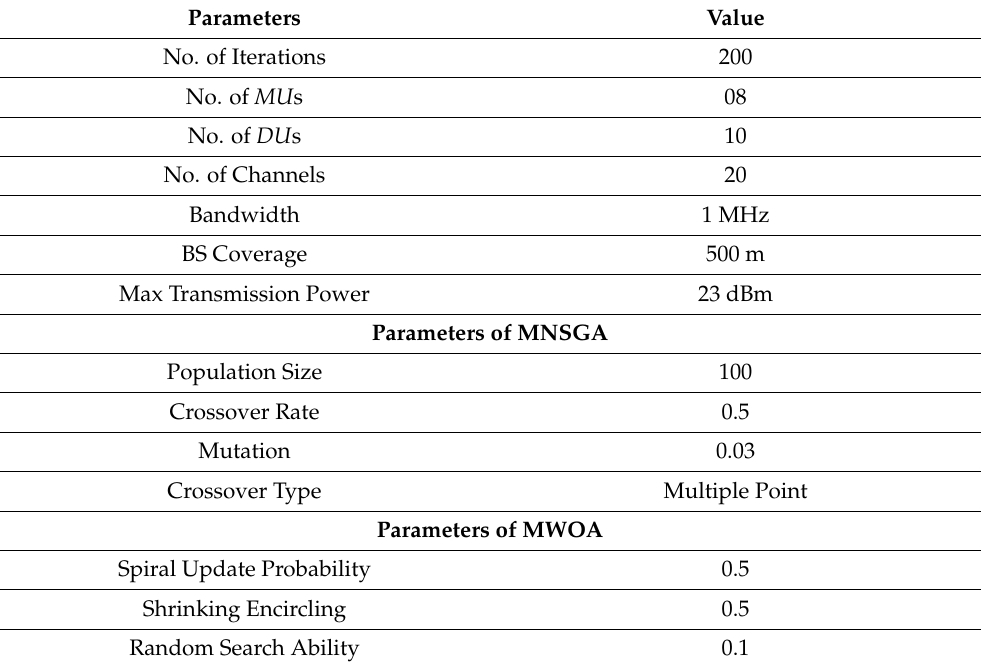
Table 1. Simulation parameters.